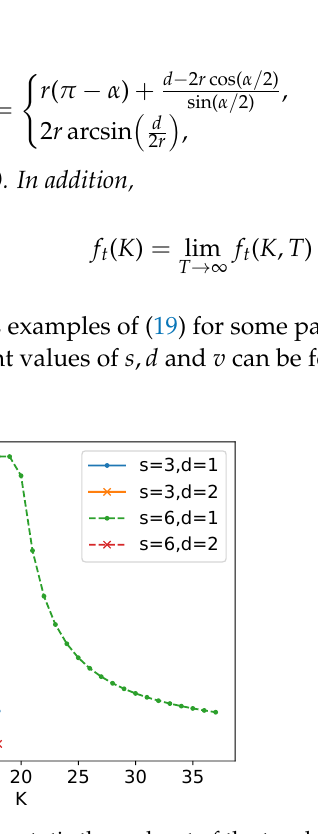
Figure 14. Plot of the asymptotic throughput of the touch and run strategy (given by (19)) for some values of s and d , in metres, and v = 1 m/s, for the interval of values for K obtained by